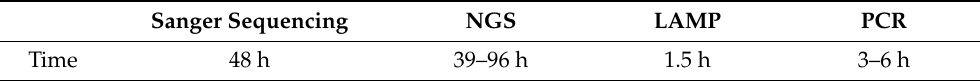
Table 2. Analysis time for different methods (with RNA extraction and reverse transcription). Sanger Sequencing NGS